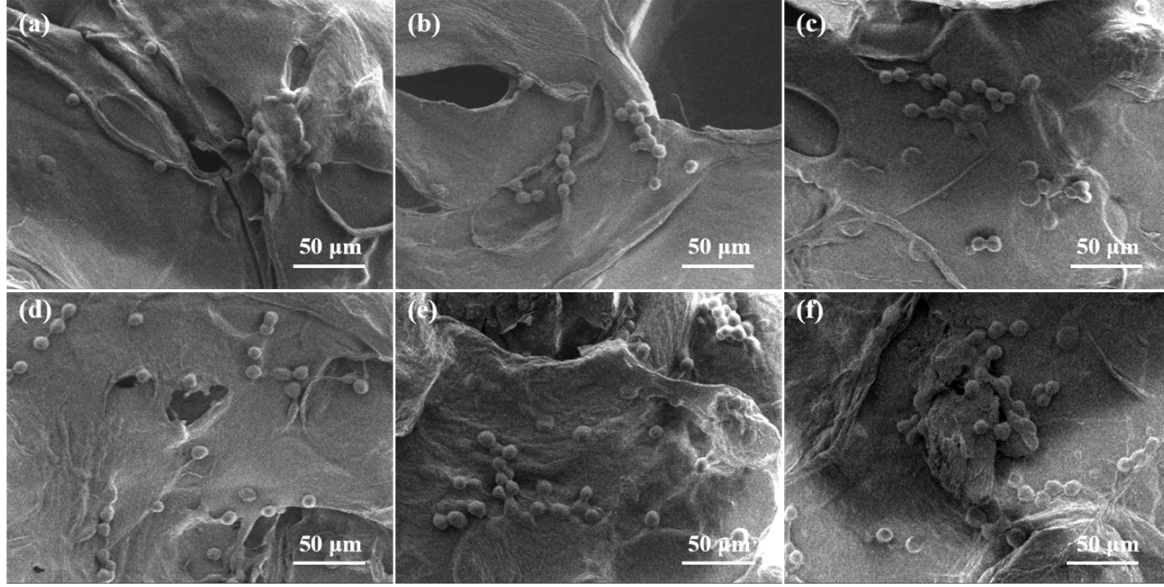
Figure 9. SEM images of osteosarcoma MG-63 cells cultured on the composite scaffolds for 2 days: ( a ) Alg-CS-GT, ( b ) Alg/0.1% BCNs-CS-GT, ( c ) Alg/0.2% BCNs-CS-GT, ( d ) Alg/0.3% BCNs-CS-GT, ( e ) Alg/0.4% BCNs-CS-GT and ( f ) Alg/0.5% BCNs-CS-GT.